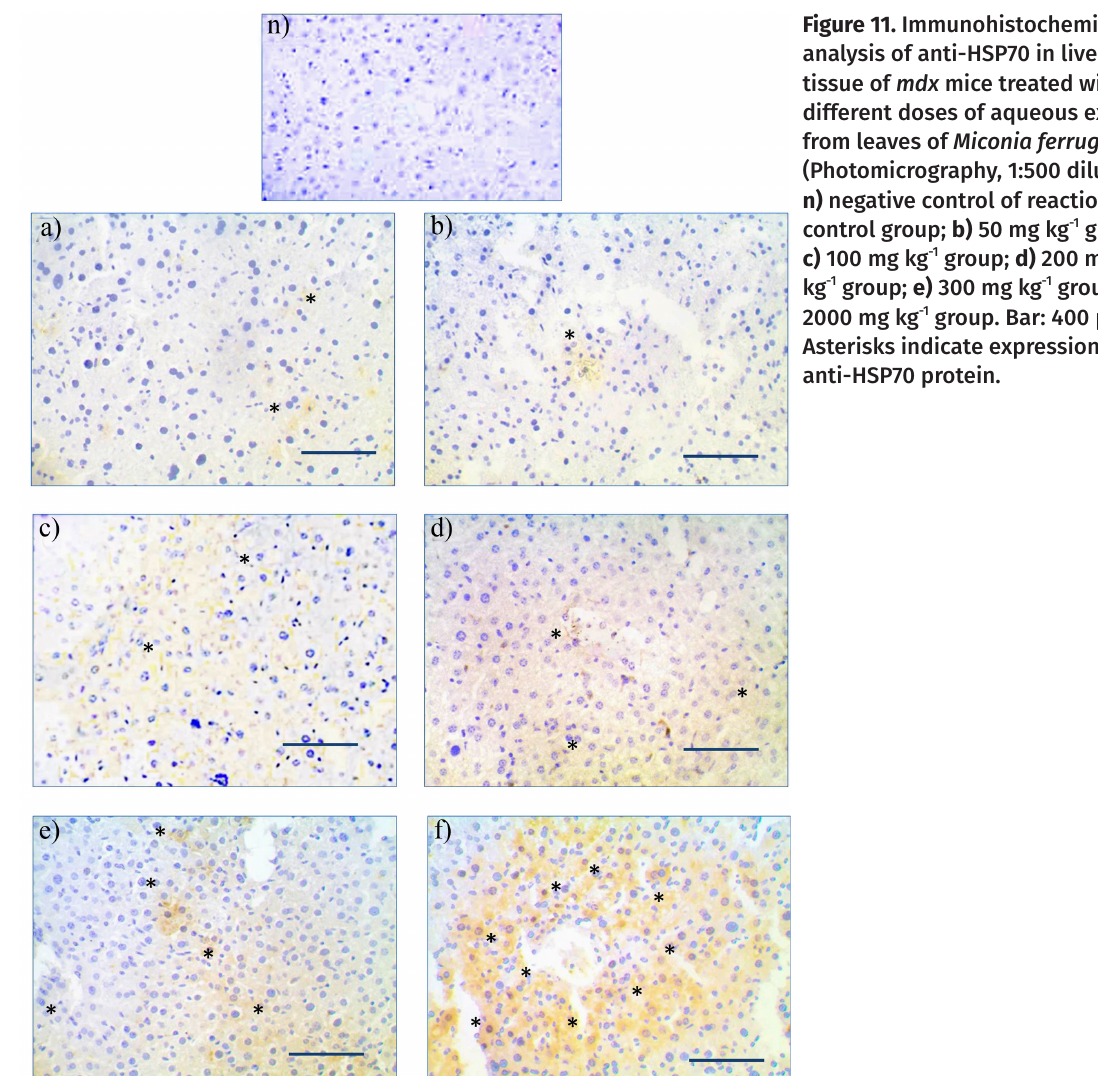
REGENERATIVE DOSE OF M. ferruginata IN mdx MODEL